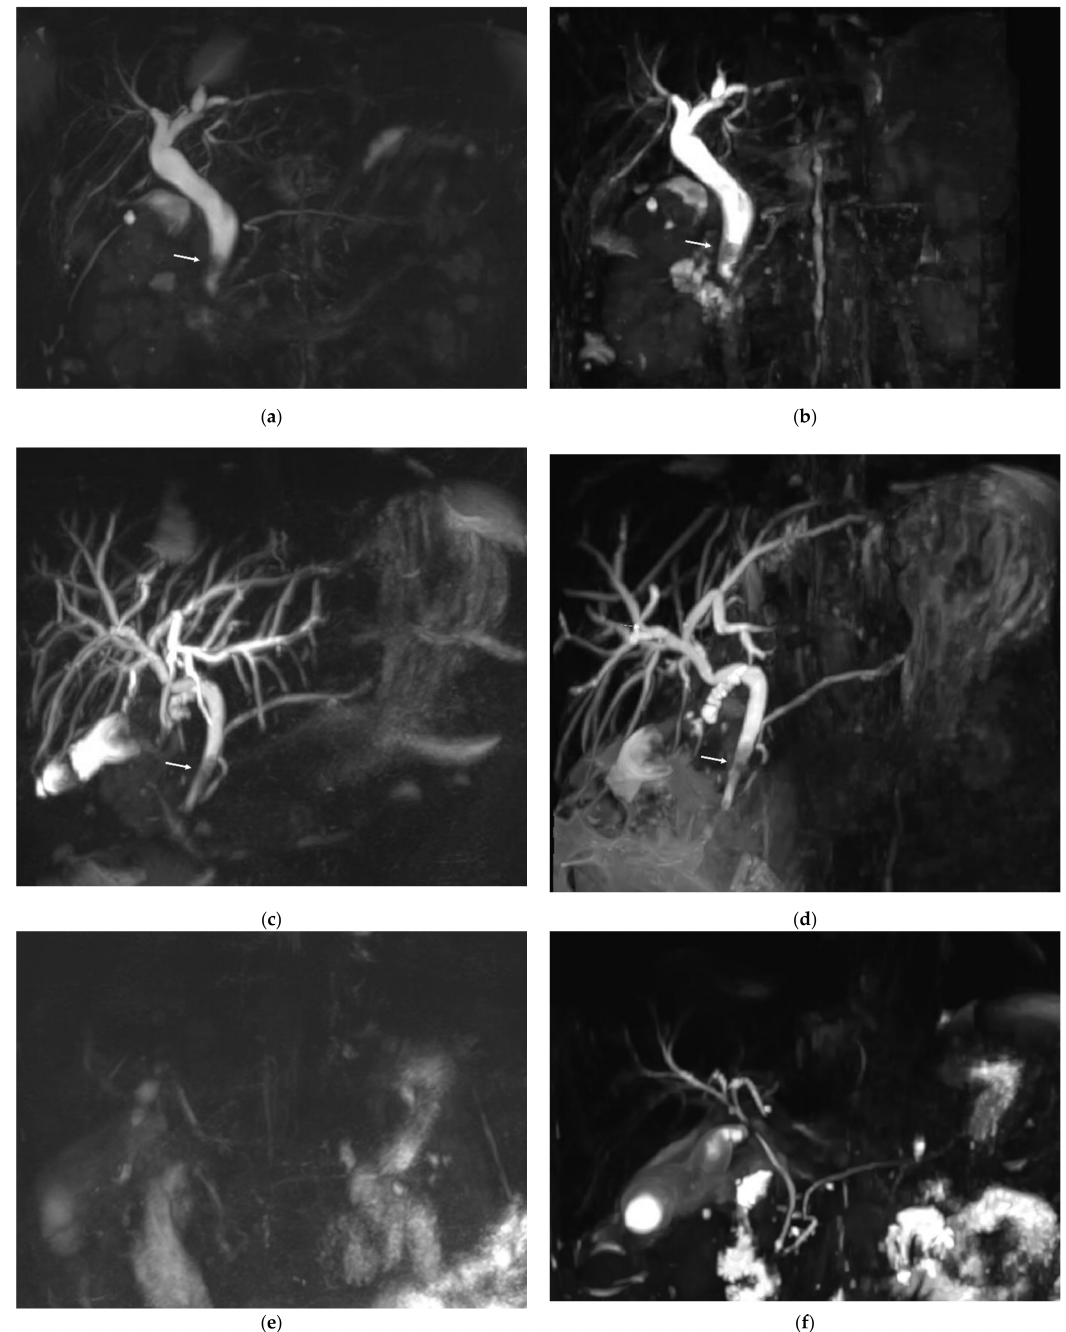
Figure 4. Three examples of MRCP images of patients referred for suspected choledocholithiasis using RT-MRCP and CS-BH-MRCP sequences. ( a , b ) MRCP images from a 41-year-old female. The stone within the common bile duct (arrow) was clearly seen with both RT-MRCP ( a ) and CS-BH-MRCP ( b ) sequences with a diagnostic confidence score of 3. RT-MRCP acquisition time was 4 min 30 s. ( c , d ) MRCP images from a 61-year-old female. Both RT-MRCP ( c ) and CS-BH-MRCP ( d ) sequences showed intra-hepatic bile duct dilation upstream of calculi (arrows) in the common bile duct with a diagnostic confidence score of 3. RT-MRCP acquisition time was 3 min 23 s. ( e , f ) MRCP images from a 55-year-old male. ( e ) RT-MRCP showed very poor image quality and was uninterpretable. The diagnostic confidence was scored 1. ( f ) CS-BH-MRCP showed better image quality, with a diagnostic confidence score of 2, allowing moderate confidence to diagnose the absence of CBD lithiasis. RT-MRCP acquisition time was 14 min 41